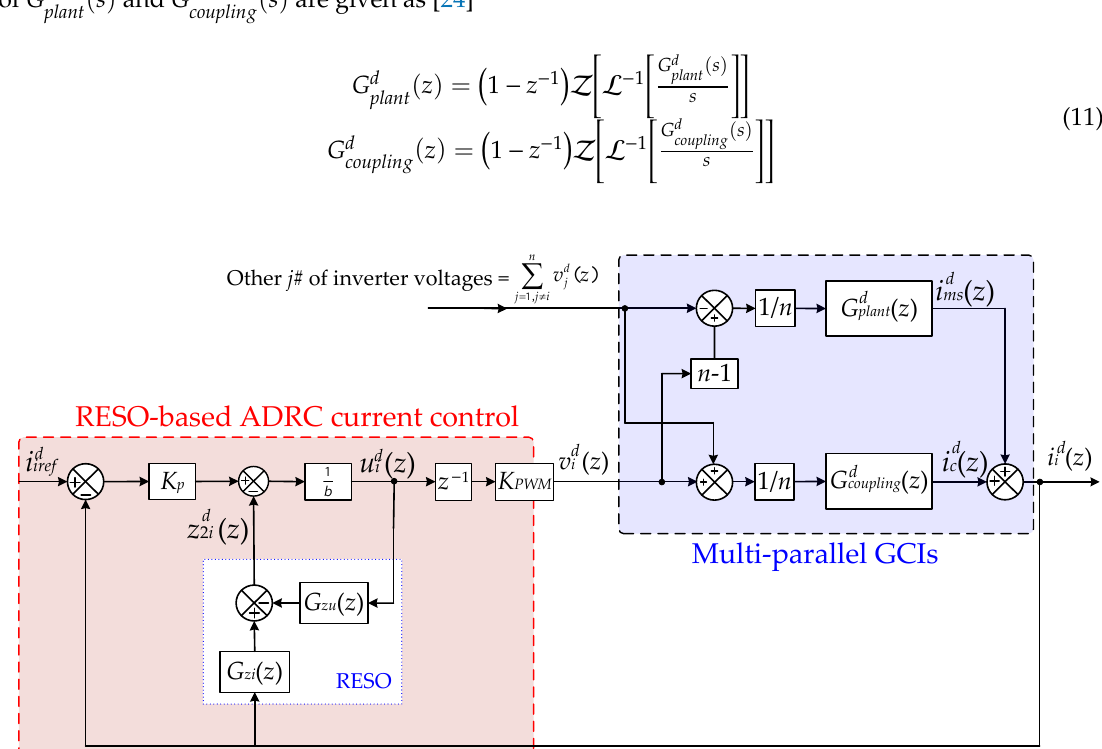
Figure 3. Overall system with the proposed RESO-based ADRC current control scheme. Proposed RESO-based first-order ADRC current control scheme for multi-parallel GCIs.